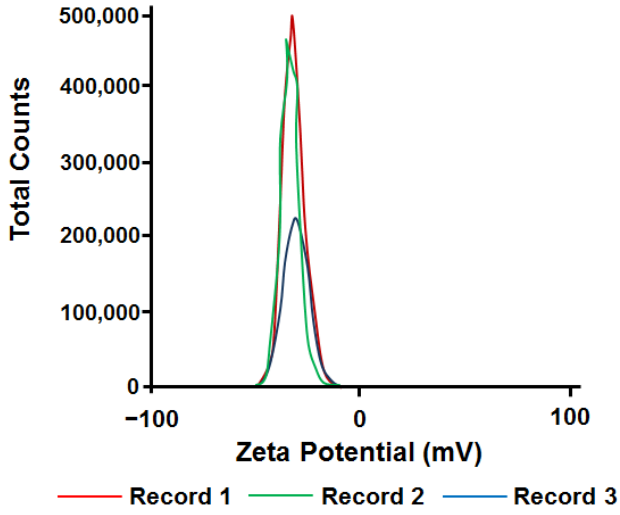
Figure 3. Zeta potential of CuO NPs in 1 g/L suspension.